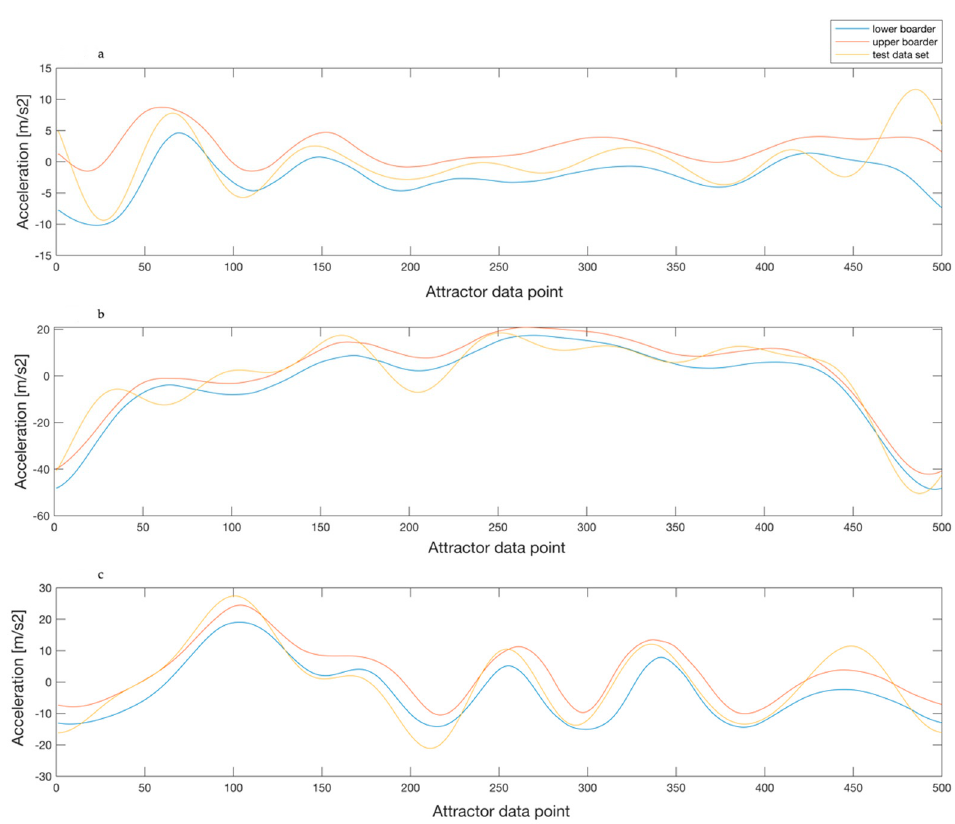
Figure 7. Display of the recognition horizon (blue and orange) with a data set from a di ff ering subject over all three axes ( a = x -axis, b = y -axis, c = z -axis). The recognition rate was 44%.